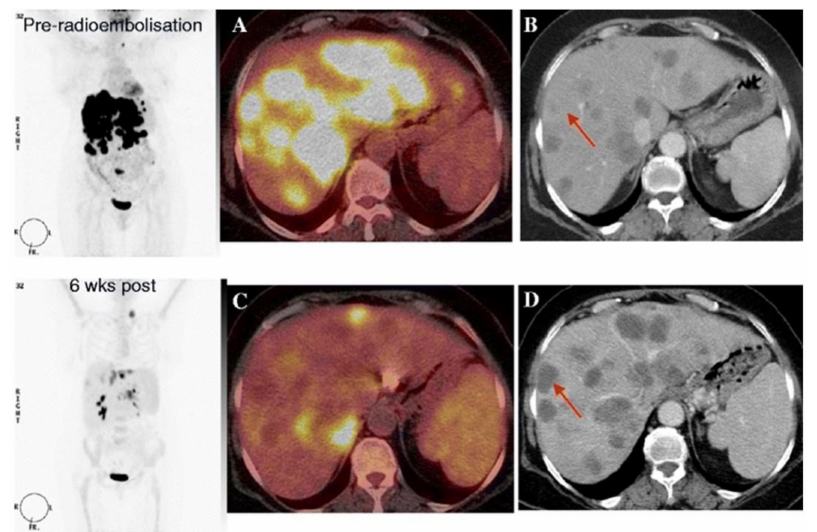
Figure 4. 18 F-FDG PET-CT images before and 6 weeks after radioembolization. Coronal PET-only images (left panel), fused 18 F-FDG PET-CT images ( A , C ), and contrast-enhanced CT images ( B , D ). Pretreatment 18 F-FDG PET-CT and contrast-enhanced CT images show multiple hepatic lesions ( A , B ). Posttreatment 18 F-FDG PET-CT imaging shows a partial metabolic response ( C ), whereas contrast- enhanced CT imaging suggests progressive disease. Adapted from: The role of early 18 F-FDG PET/CT in prediction of progression-free survival after 90Y radioembolization: comparison with RECIST and tumour density criteria. I. Zerizer et al. Eur J Nucl Med Mol Imaging. 2012 Sep;39(9):1391-9. doi: 10.1007/s00259-012-2149-1. Epub 2012 May